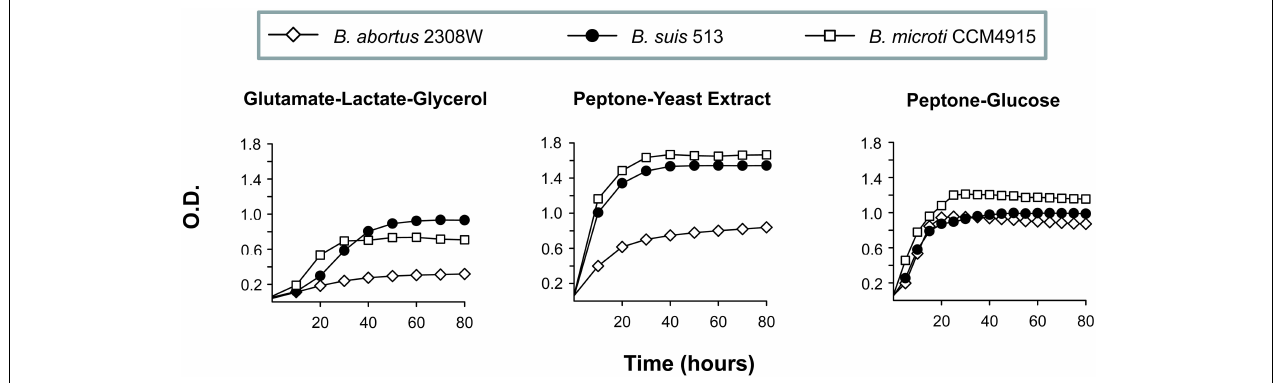
FIGURE 2 | Growth curves in glutamate-lactate-glycerol, peptone-yeast extract, and peptone-glucose of B. abortus 2308W, B. suis 513, and B. microti CCM4915. Each point represents the mean ± standard error (error bars are within the size of the symbols) of optical density (OD) values of triplicate samples. The experiment was repeated three times with similar